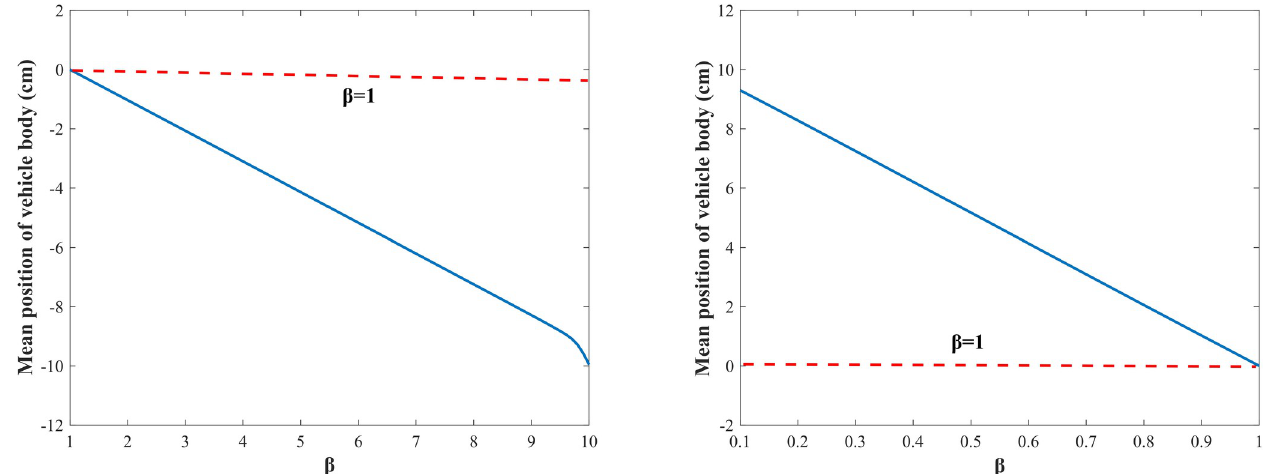
Fig 6. Vehicle body’s mean position at different β . (A) Vehicle body drops; (B) Vehicle body raises.